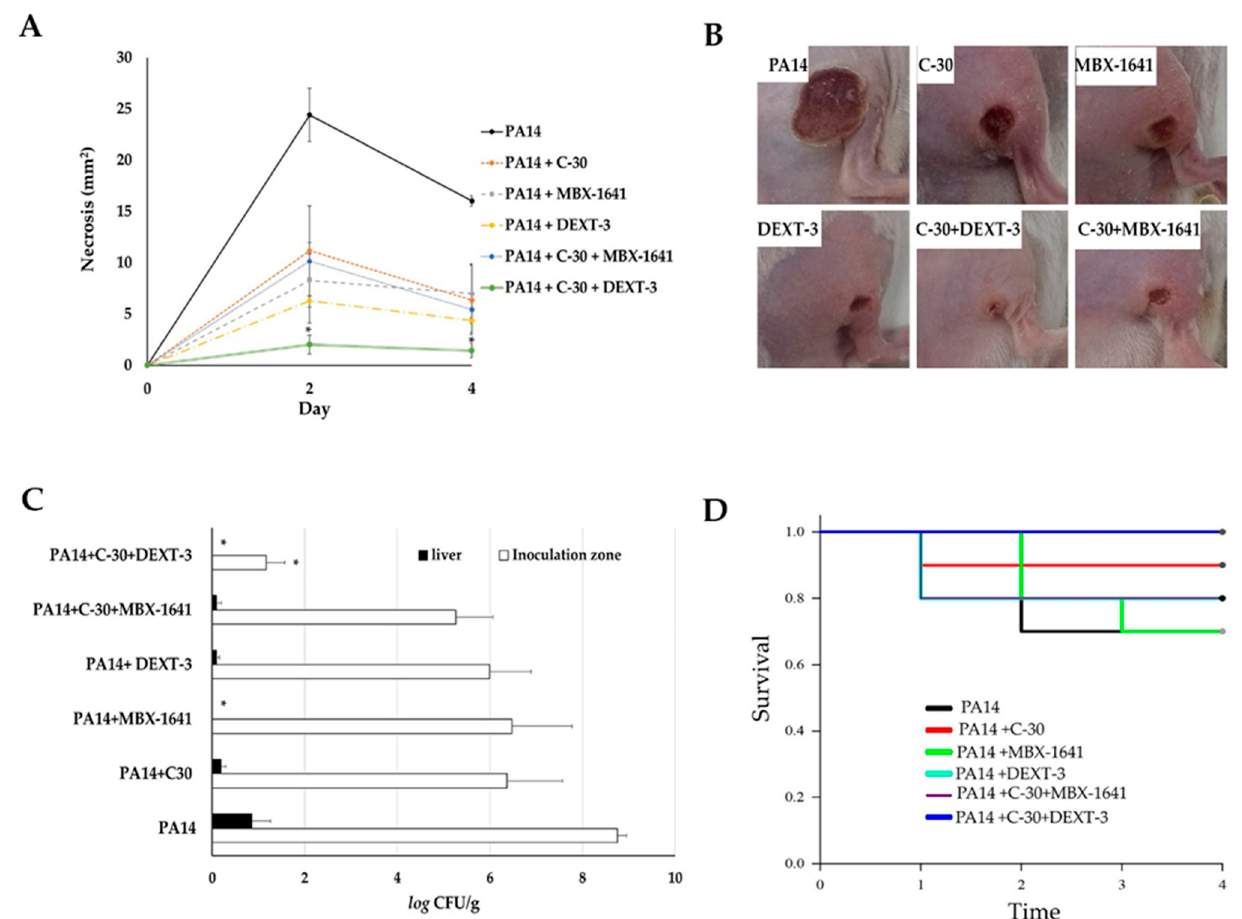
Figure 5. The antipathogenic activity of C-30 (QS inhibitor), MBX-1641 (T3SS inhibitor), DEXT-3, and C-30/DEXT-3 and C-30/MBX-1641 combinations in a model of infection and necrosis induced by P. aeruginosa . Mice intraperitoneally inoculated with P. aeruginosa PA14 WT strain (1 × 10 7 CFU) were treated separately with C-30 (50 µM), MBX-1641 (200 µM), DEXT-3 (100 µM), and C-30 (50 µM) + MBX-1641 (200 µM), and C-30 (50 µM) + DEXT-3 (100 µM) combinations ( A ) Induction of necrosis. ( B ) Representative images of in situ damage. ( C ) Bacterial load in the inoculation area (CFU in tissue) and systemic dispersion (CFU in liver), * α = 0.05. ( D ) Kaplan-Meier survival curve, performed with the GraphPad Prisma 6 program (95% confidence interval) and the data analysis in the SPSS 22.0 program. The data are representative of two experiments ( n = 5).